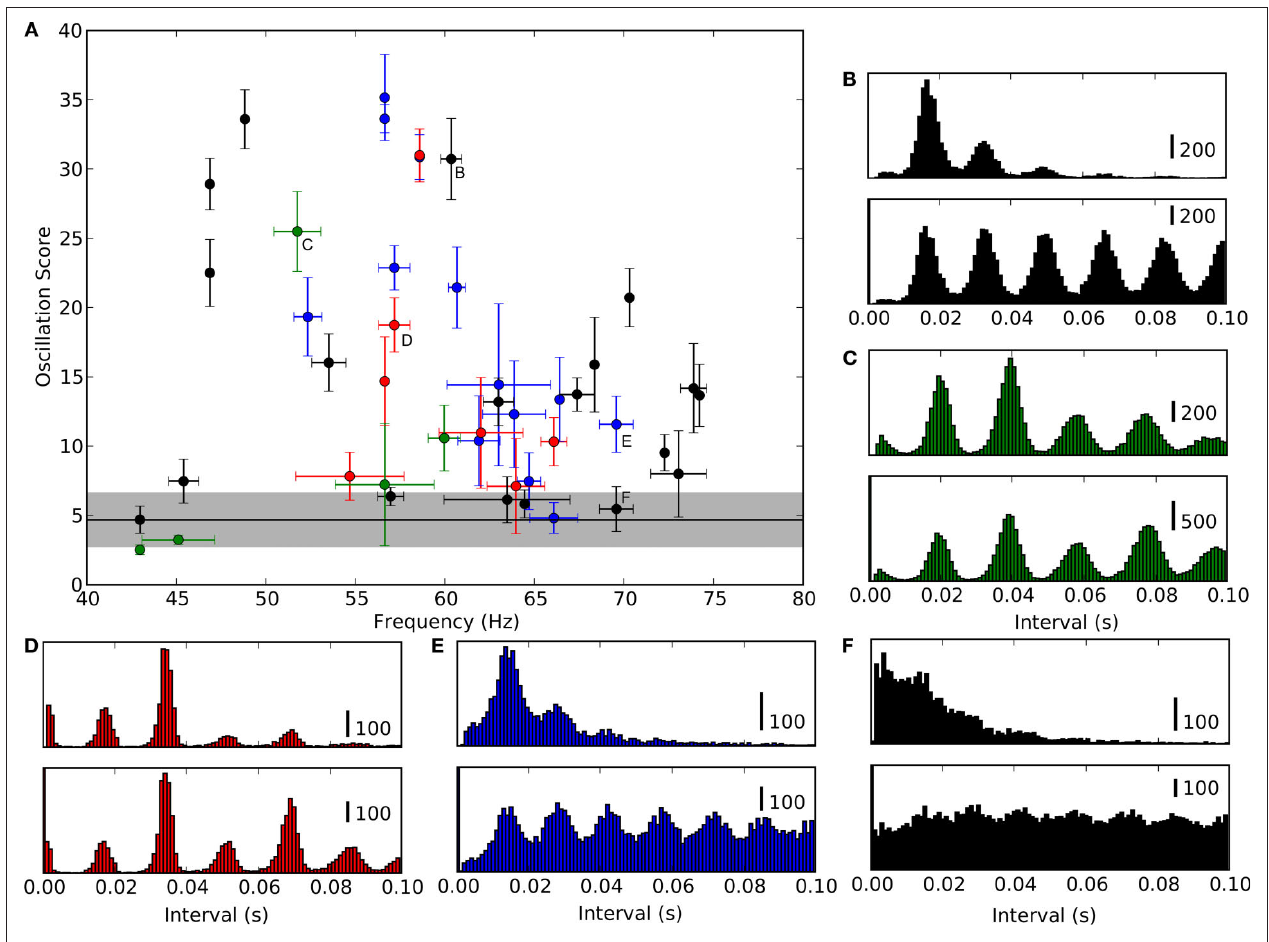
recorded retinal spikes, green. The shaded region shows the range of scores for > 4, see Table 1 and main text). Lettered cells that did not oscillate consistently ( σ f points refer to corresponding panels, (B–F) , which show spike interval histograms (top) and autocorrelograms (bottom) for cells with different oscillation